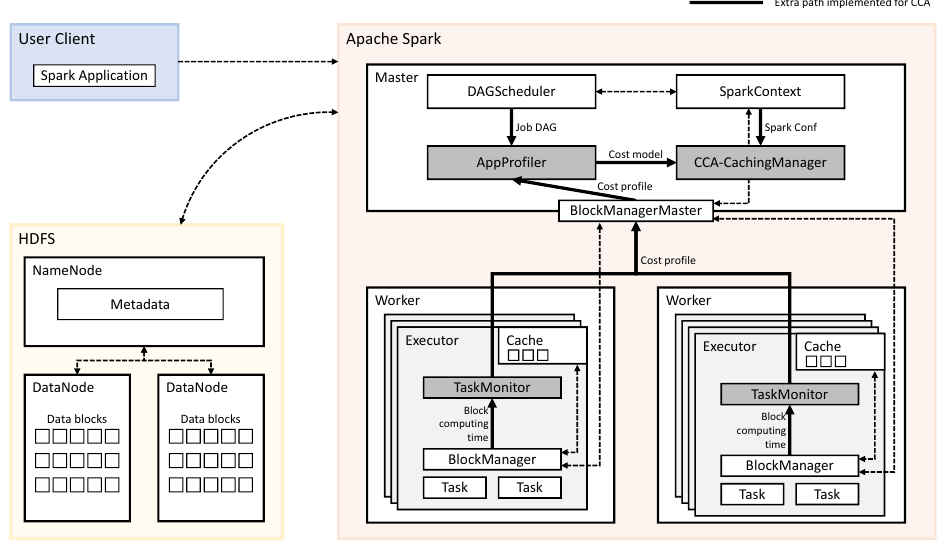
Figure 5. Architecture of cost-capacity-aware caching